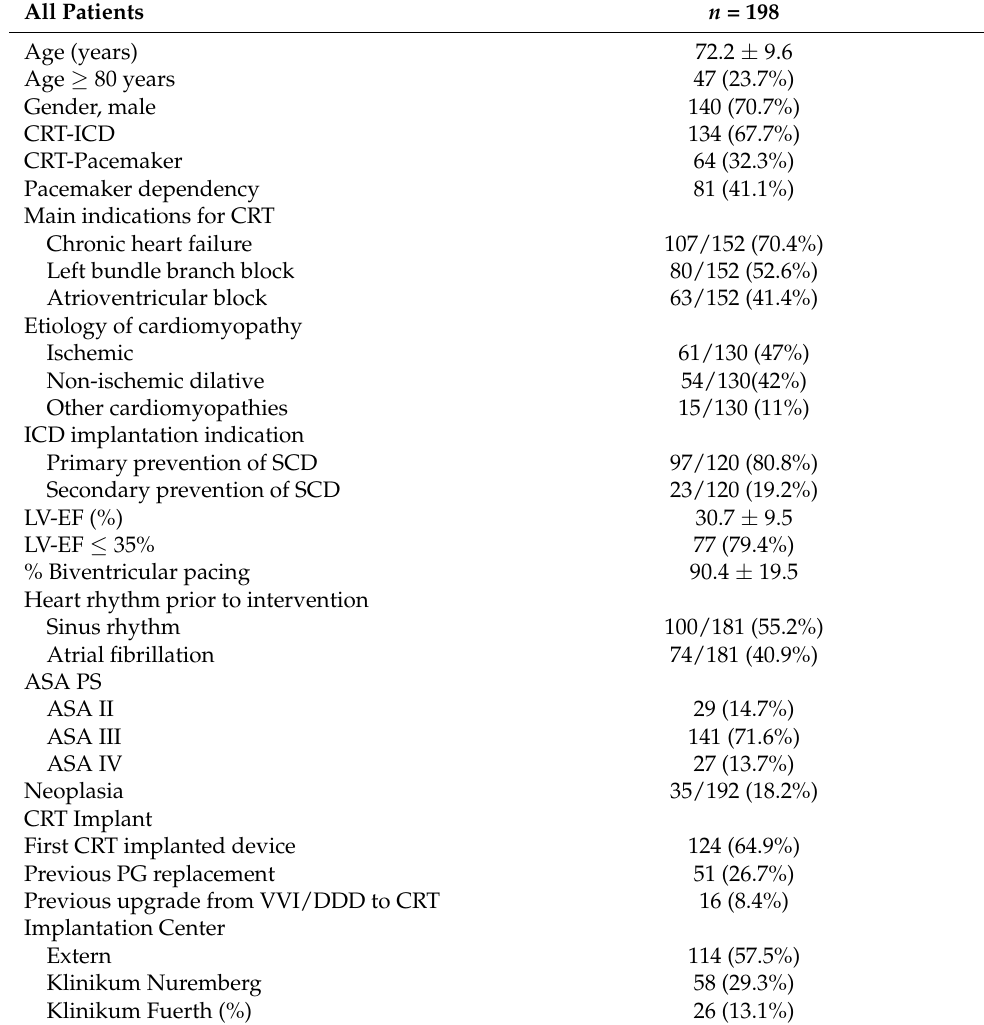
Table 1. Baseline